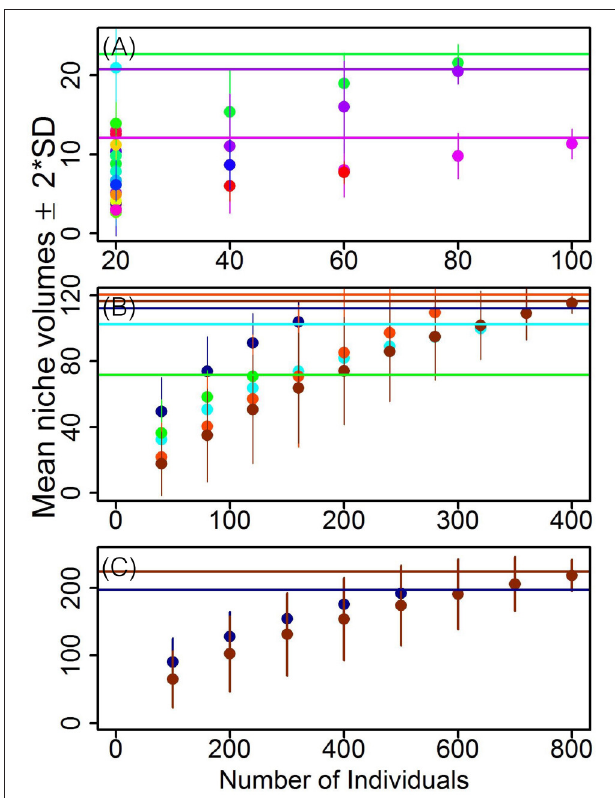
FIGURE 11 | Mean niche volumes ( ± 2*SD ∼ 95% CI) after 999 randomized permutations on increasing number of individuals of: (A) species; (B) trophic groups: aquatic detritivores (light blue) and predators (dark blue), terrestrial herbivores (green), detritivores, (red) and predators (dark brown); and (C) aquatic (dark blue) and terrestrial (dark brown) habitats. Horizontal lines indicate the total niche volume of a given grouping variable (i.e., species, trophic groups, habitats). Note that for the sake of visual clarity in (A) total niche volumes were shown only for three species that have > 80 individuals (i.e., Lepisma sp.—green, Salticidae sp.—light purple, and Pysogaster sp.—dark purple). In addition, Mecystogaster modesta is in light blue (topleft in A ; cf main